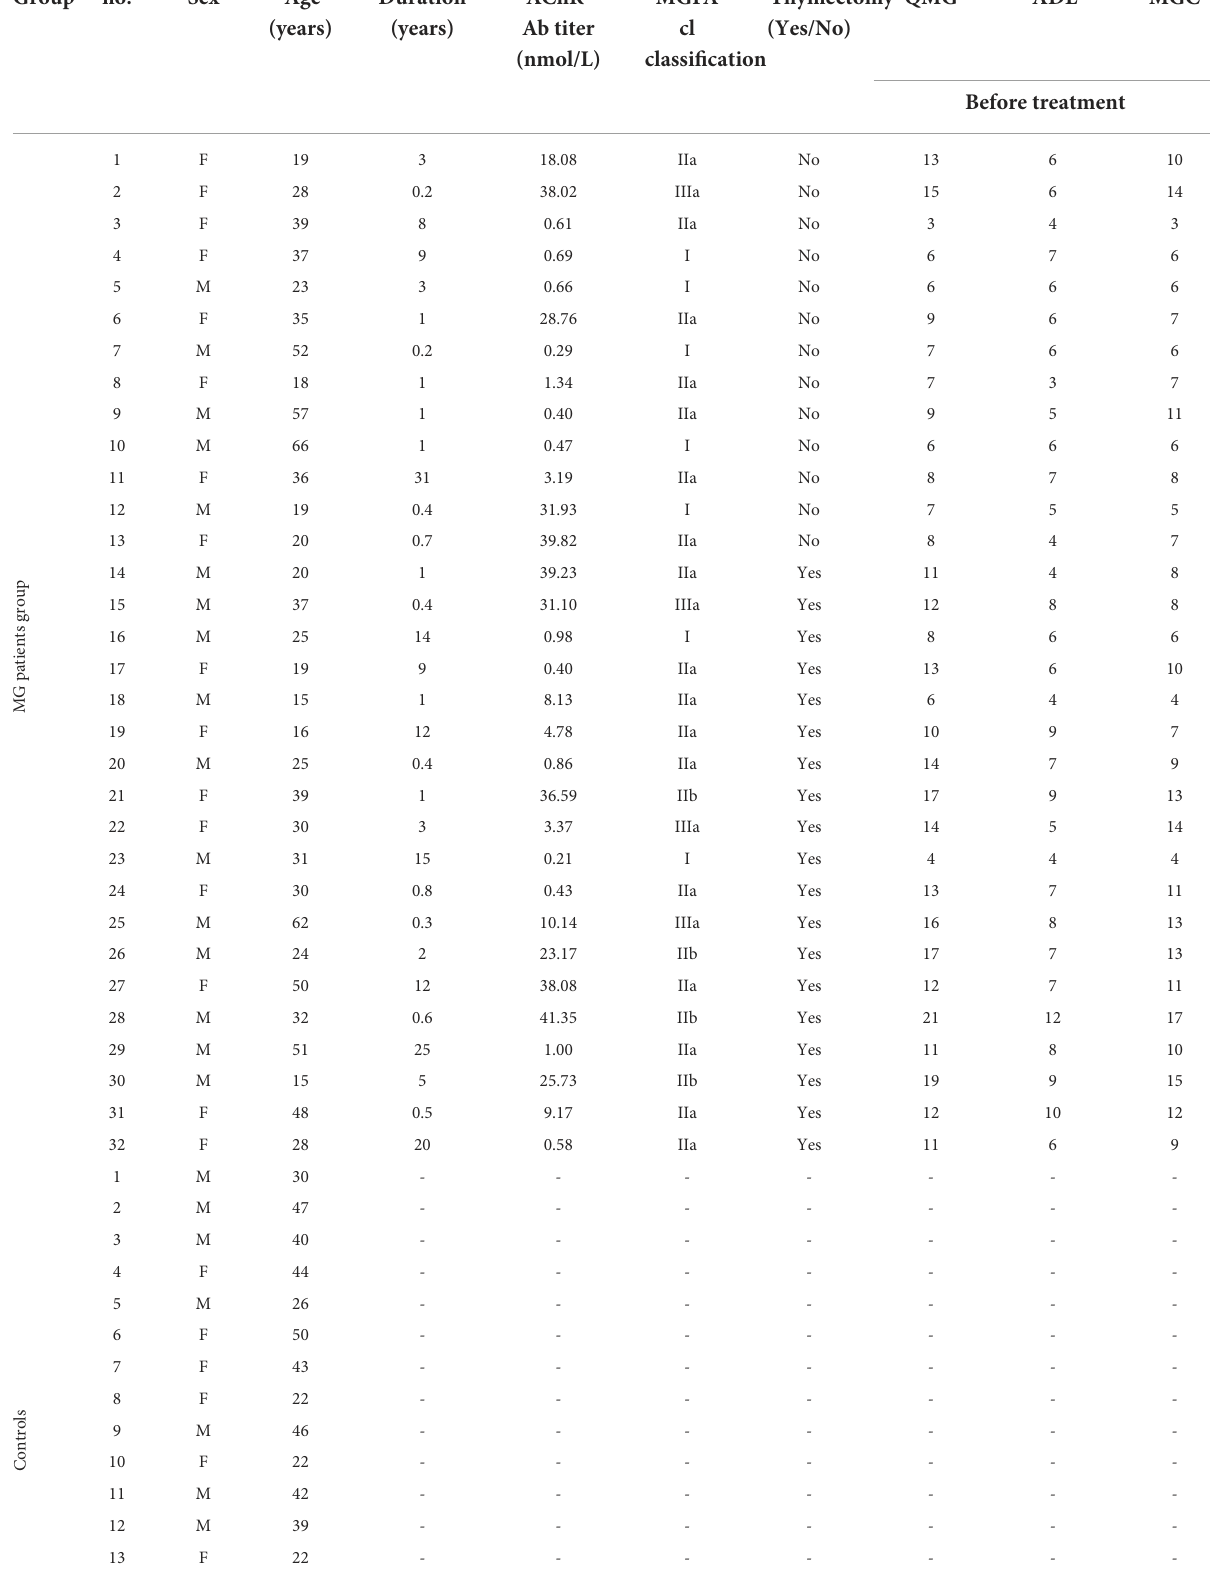
TABLE 1 Basic information for the patients treated with leflunomide and low-dose prednisone.